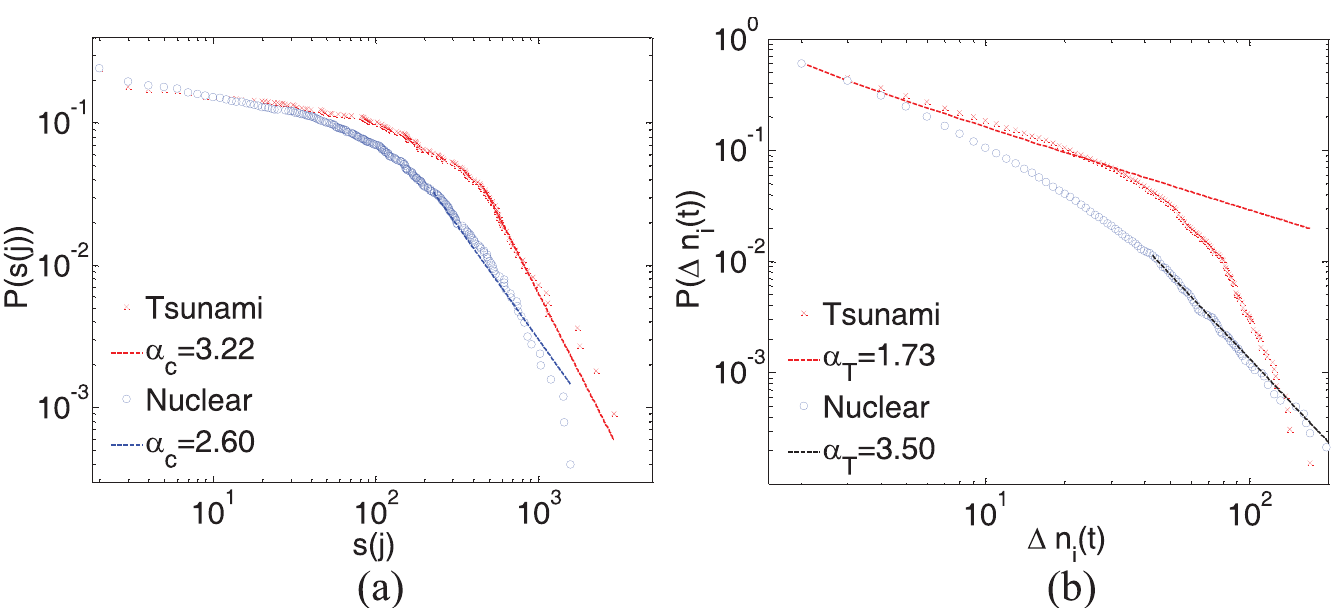
Fig 1. Distributions of collective online behaviors. (a) the cumulative distribution of solo tweets about two hashtags and their exponents α c , and (b) the corresponding distribution of incremental tweets about two hashtags and their exponents α t . All exponents are estimated by applying KS statistical test.